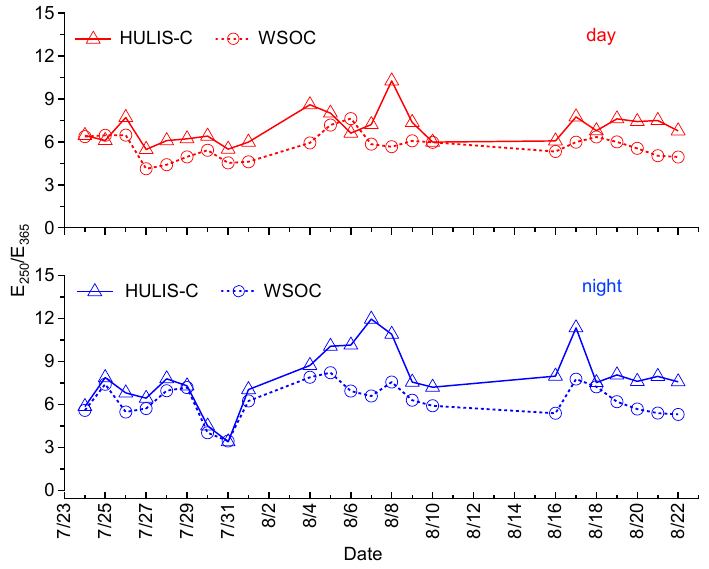
Figure 7. Temporal variation of E 250 /E 365 of HULIS-C (hollow triangles) and WSOC (hollow circles) for daytime (top panel) and nighttime samples (bottom panel).